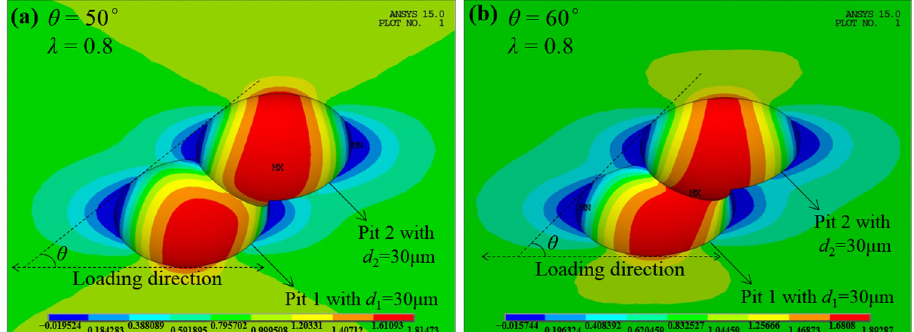
Figure 6. The comparison of stress contours with different inclination angle θ for the P sh -P id case ( d 1 = d 2 = 30 μ m) when λ = 0.8 and θ th = 55°. ( a ) θ < θ th ; and ( b ) θ > θ th .